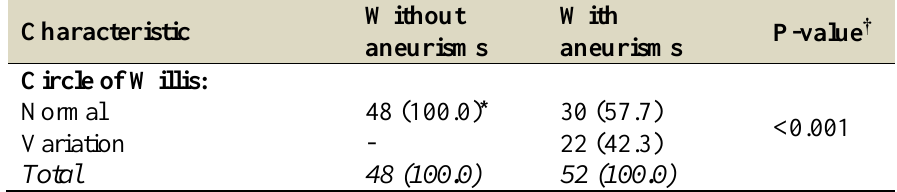
Table 4. Anatomical variations of the circle of Willis by presence of aneurisms among